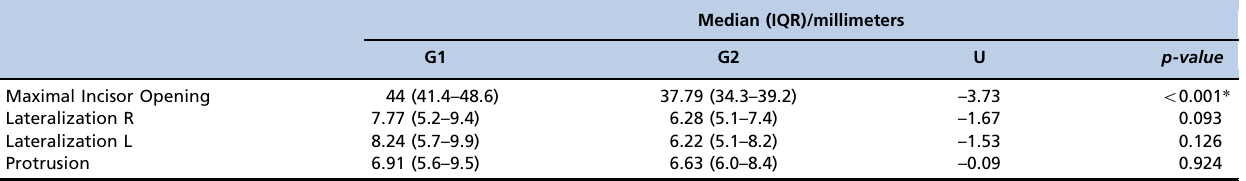
Table 2 - Evaluation of the mandibular range of movement in deep partial-thickness burns – G1 (n=19) and full-thickness burns – G2 (n=21).